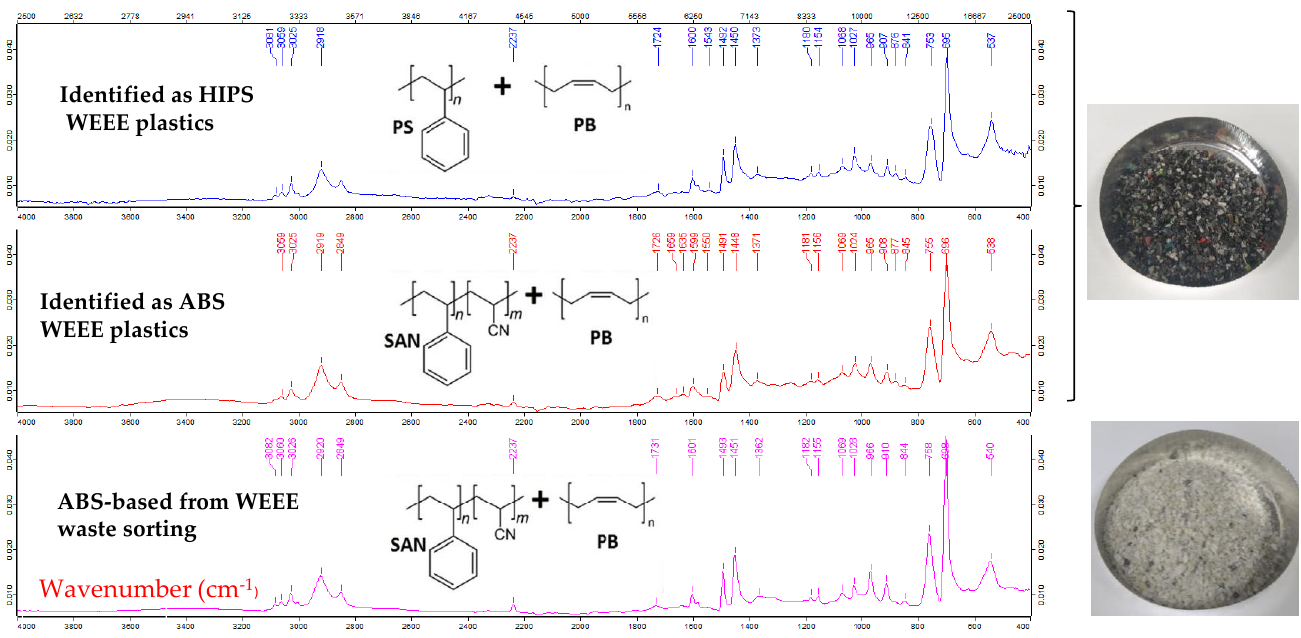
Figure 3. Identified FTIR with ATR mode as ABS-HIPS-based WEEE wastes (denoted (a) in Figure 1), and as ABS-based from WEEE waste sorting (denoted (b) in Figure